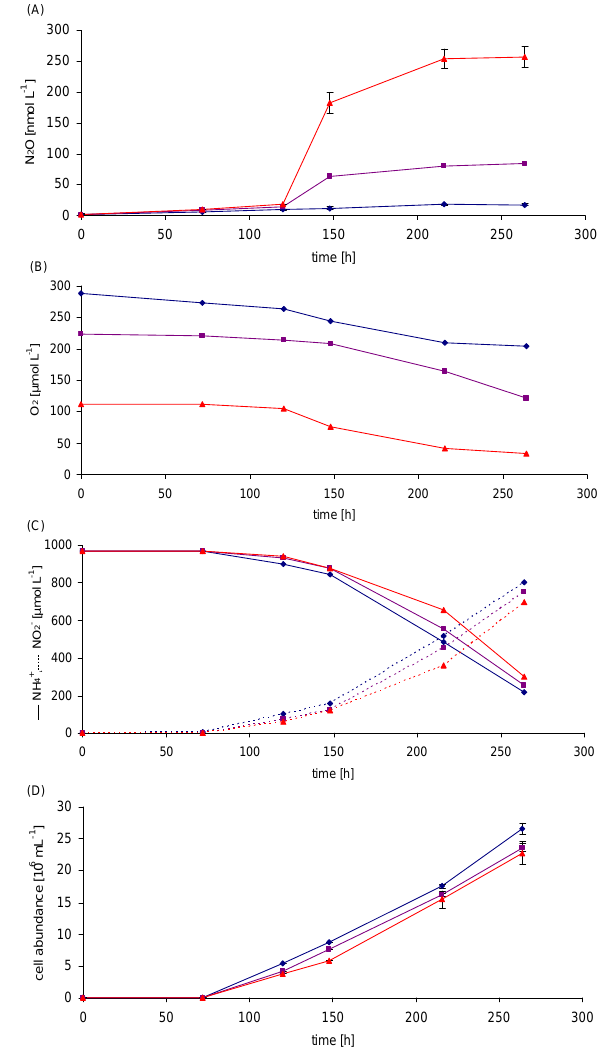
Fig. 7. N 2 O (A) , O 2 (B) , NH + and NO − (C) as well as cell 4 2 abundances (D) determined from incubation experiments with pure cultures of N. maritimus. Experiments are colour-coded accord- ing to their initial O 2 concentrations: red (112µmoll − 1 ) ; violet (223µmoll − 1 ) ; and blue (287µmoll − 1 ) . N 2 O and cell abundances were measured in triplicates and the associated error ranges are in- dicated (please note that in the most cases the error bars are too small to be visible in the